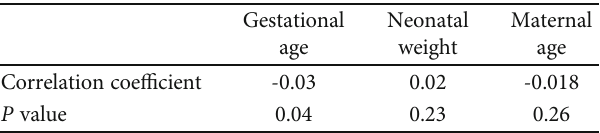
Table 6: Correlation of total bile acid with relevant indices in women without